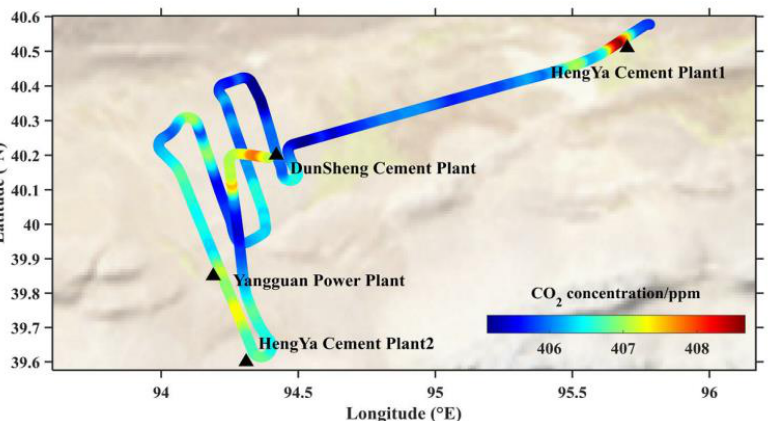
Figure 18. Atmospheric CO 2 concentration measured by airborne UGGA during the plane’s horizontal flight at an altitude of 4.05 km on 19 July 2021. The carbon dioxide emission sources on the flight track are marked with black upper triangle symbols.